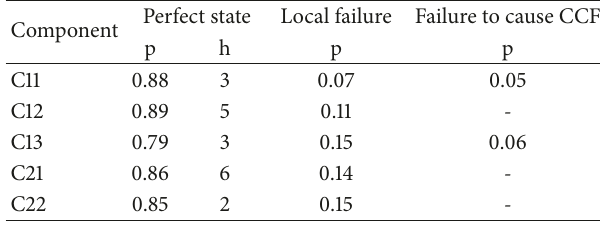
Table 1: Performance distribution of components.